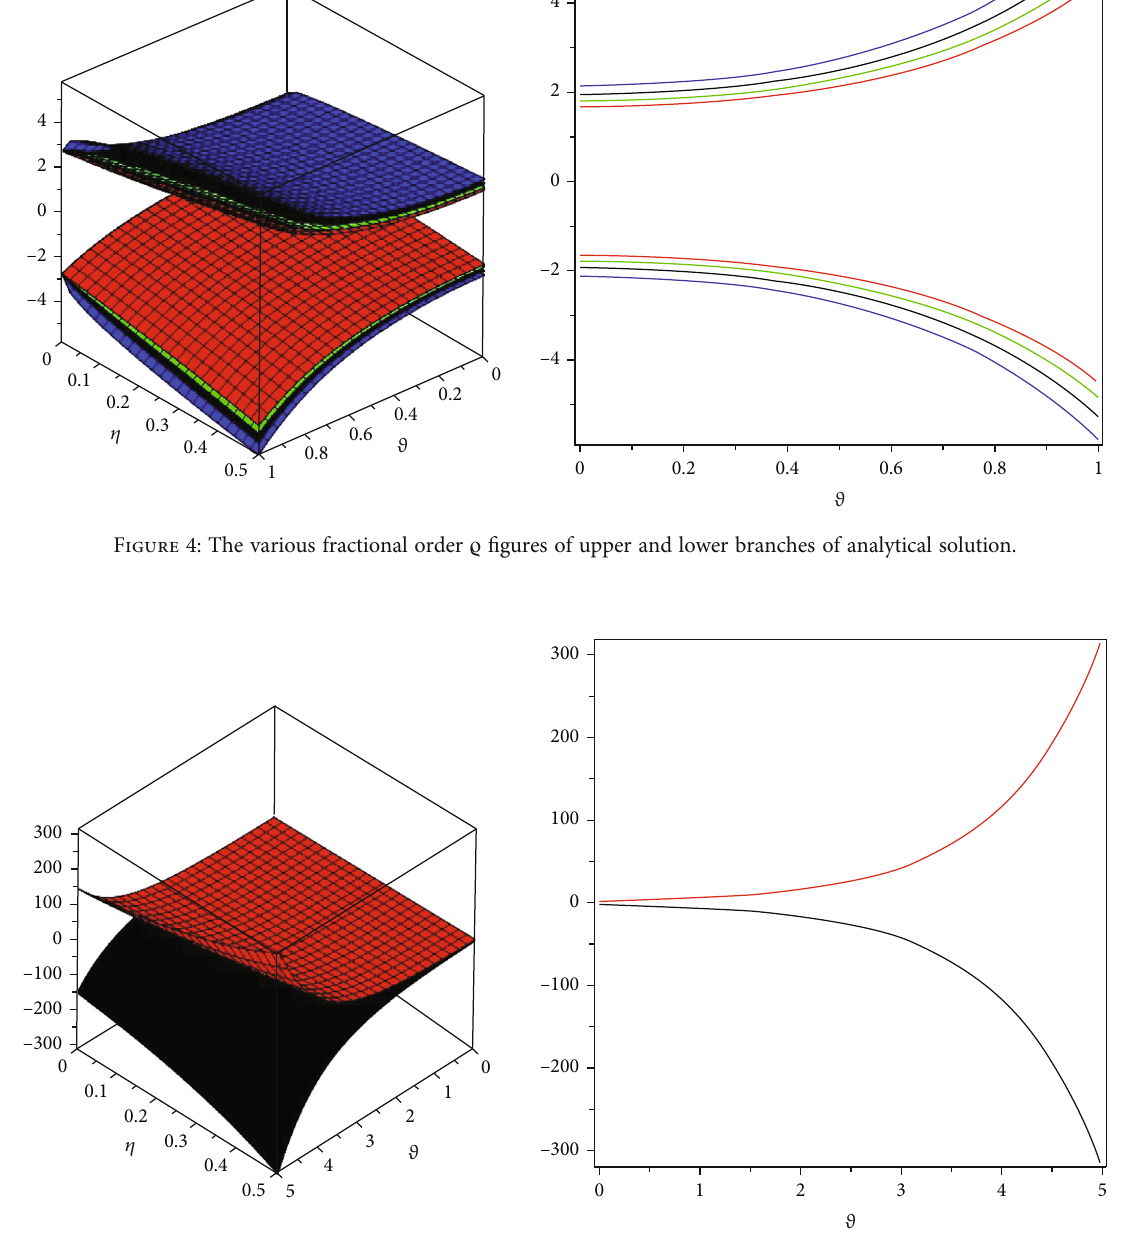
Figure 5: The fi rst fi gure shows the 3D fuzzy upper and lower branches of analytical solution at ρ = 1 and the 2nd fi gure shows the 2D fuzzy fi gure at ϱ = 1